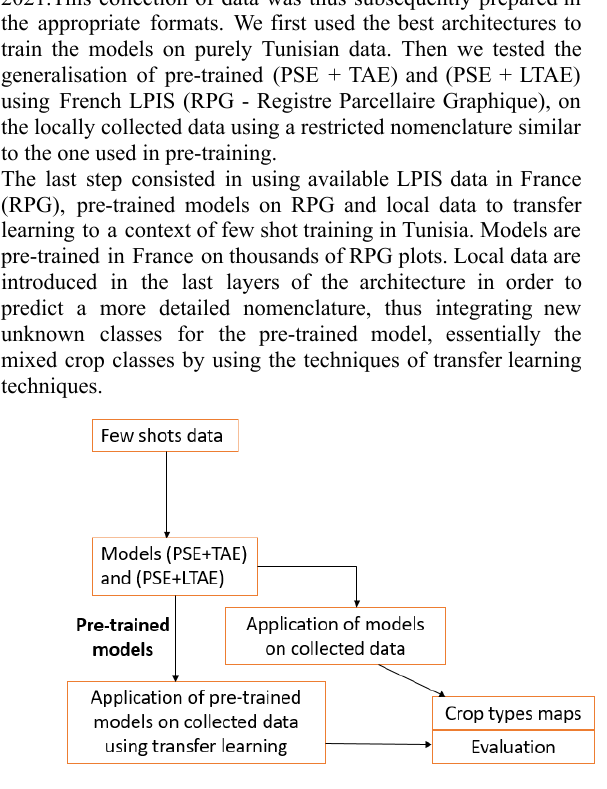
Figure 1. The proposed workflow